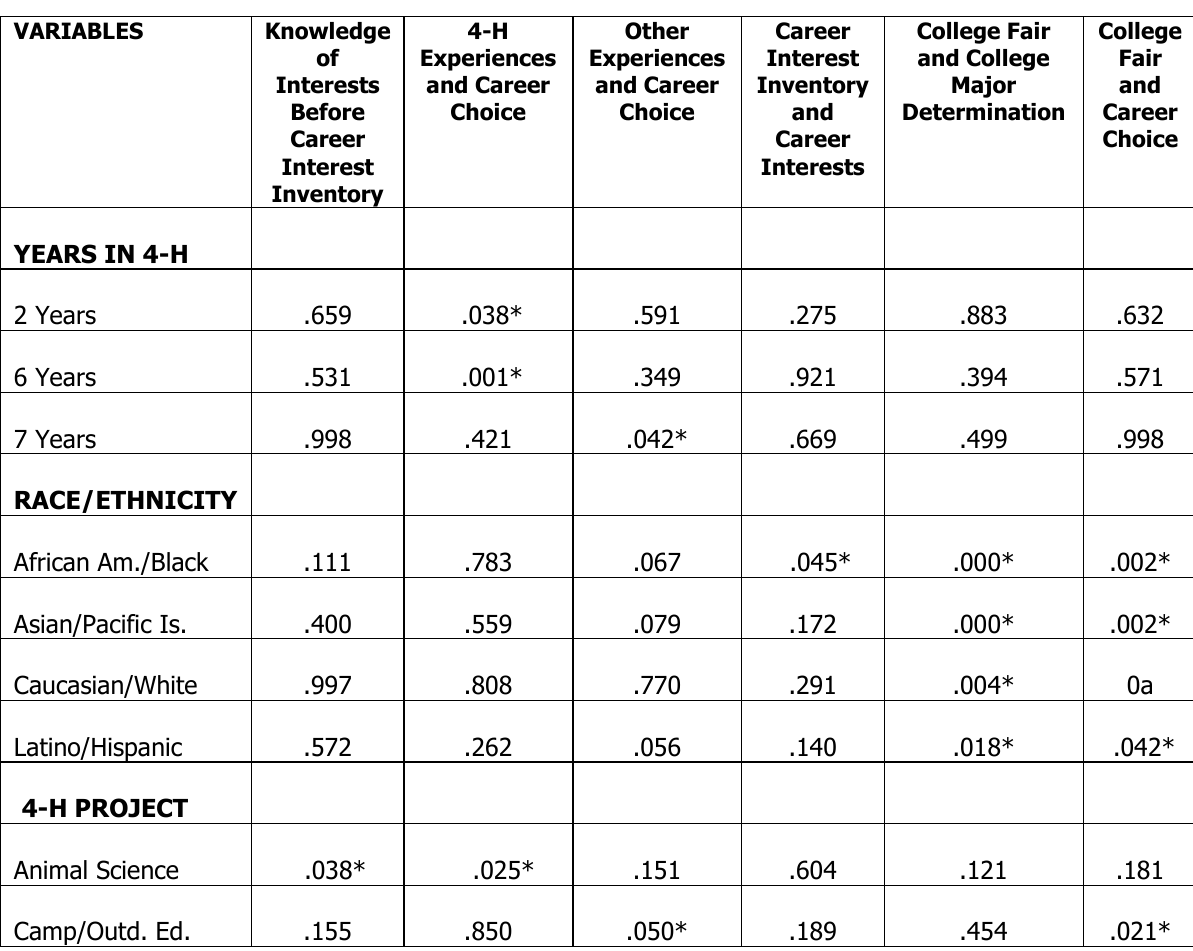
Ordinal Regression on 4-H Youths’ Career Decisions (Estimates)